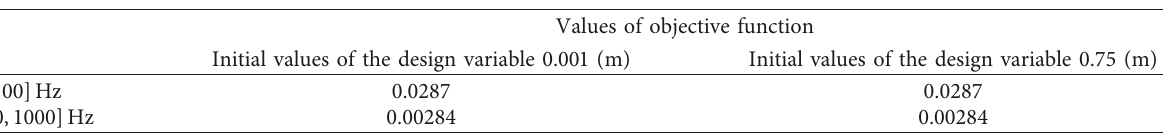
Table 2: The values of the objective function of the optimal layouts of CLD treatment.